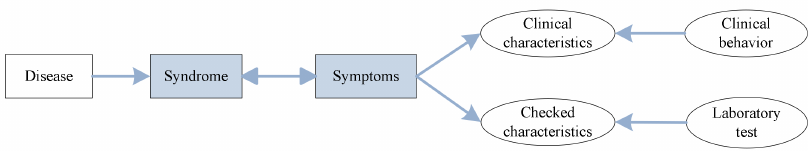
Figure 1. Relationship between symptoms and